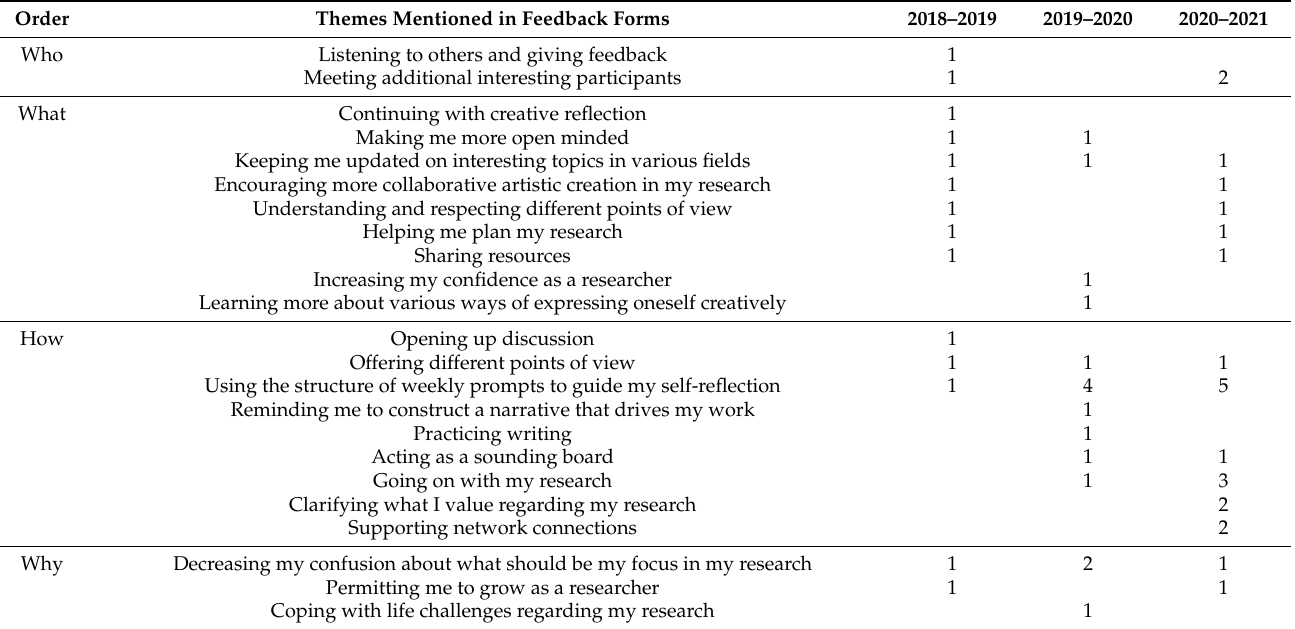
Table 5. Relevant themes mentioned in responses provided on the April feedback forms to